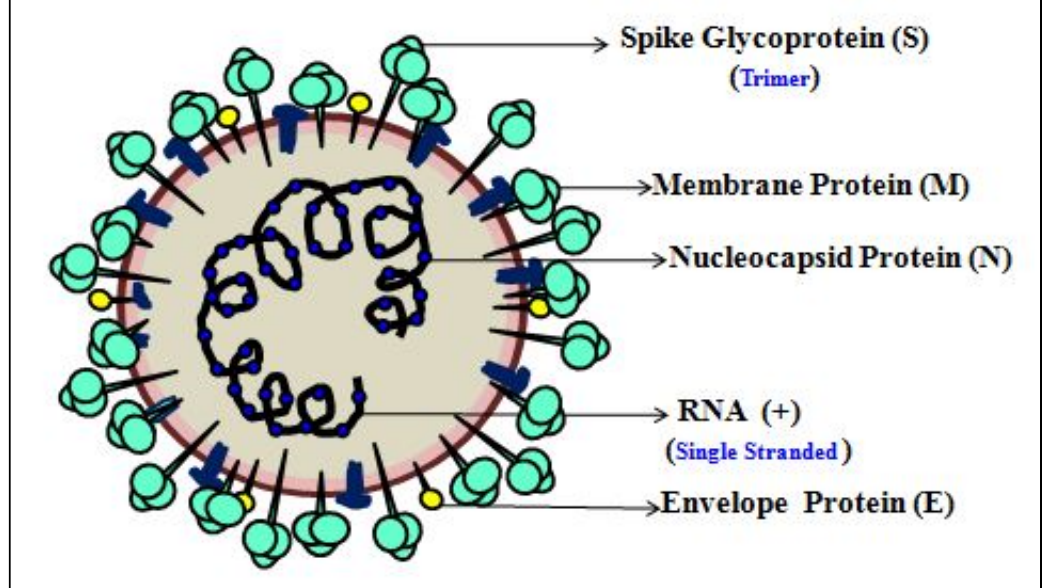
Figure 8. Structure of the SARS-CoV-2 virus. The structure of the COVID-19 virus contains the spike glycoprotein (SP), membrane protein (MP), nucleocapsid protein (NP), an envelope protein (EP), and single-stranded +RNA as the genome.